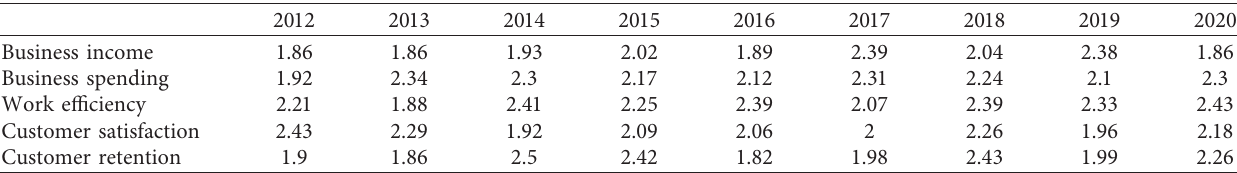
Table 1: Current status of enterprises in recent years.